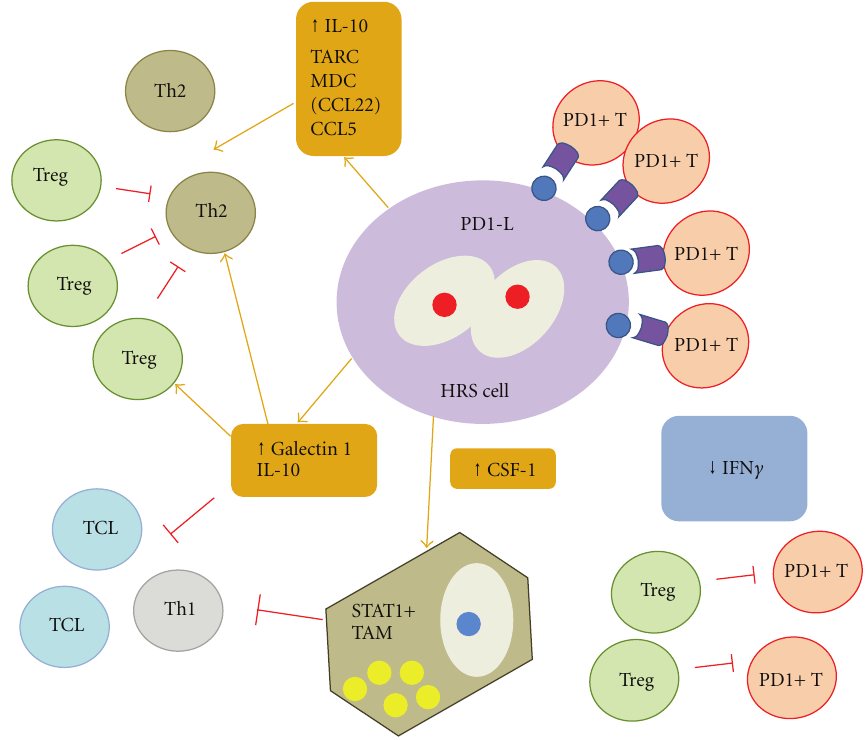
Figure 2: The HRS cell and its cellular microenvironment. Significant interactions with impact in patients outcome are depicted. Increased Galectin1 and IL-10 secreted by HRS (Hodgkin and Reed-Sternberg) cells lead to decreased TCL (T cytotoxic) and Th1 responses, together with a Treg increase which, in turn, suppresses both Th2 and PD1+ T cell activity [46–51]. PD1+CD4+ T cell activity is additionally suppressed by direct interations trough PD1-PD1L immunological synapse (T cell exhaustion) [52]. This leads to a decreased IFN γ production. Additionally, increased TAM (Tumor Associated Macrophages) contribute to T cell deletion trough STAT1 signaling pathway [53,